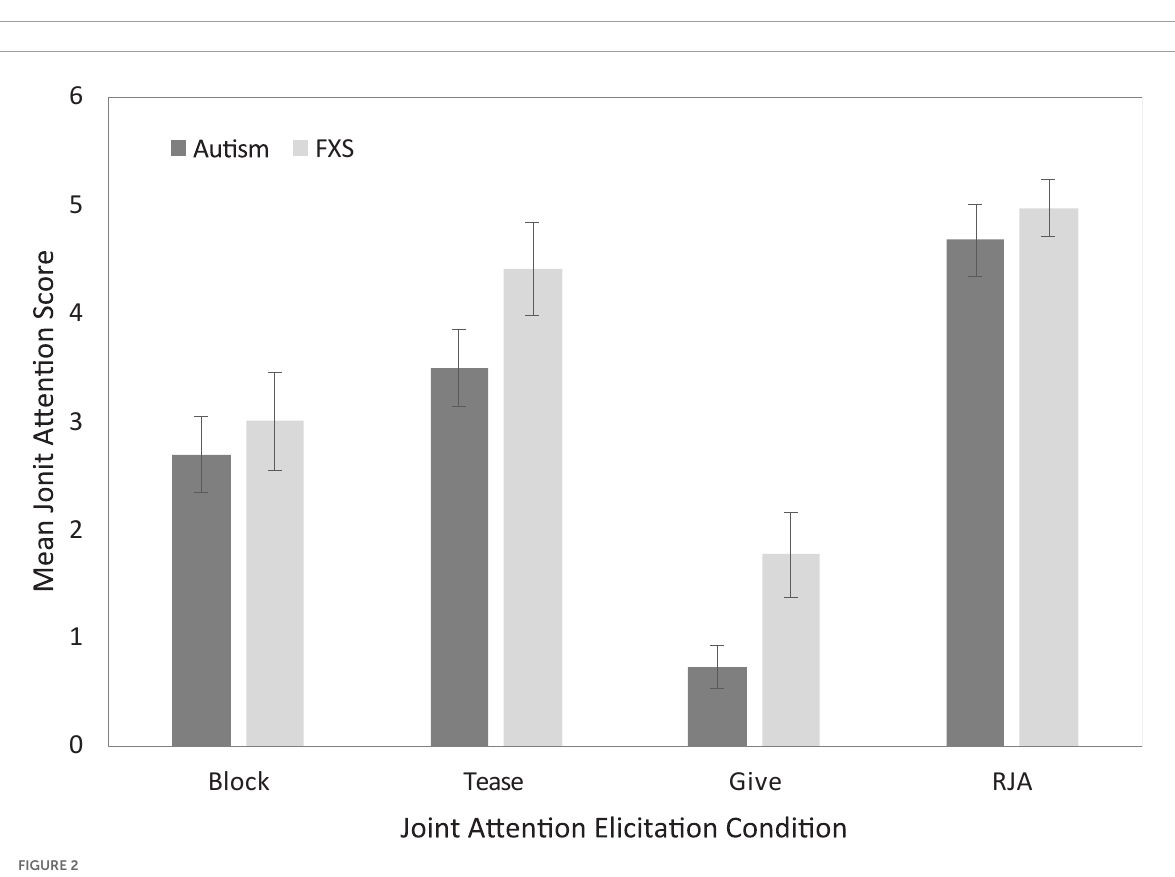
autism. All significant correlations remained after applying the FDR